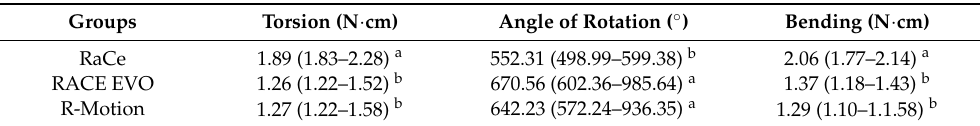
Table 2. Median, minimum (min) and maximum (max) values for torque (N · cm), angle of rotation ( ◦ ), and bending resistance (N · cm) of RaCe, RACE EVO and R-Motion NiTi files.